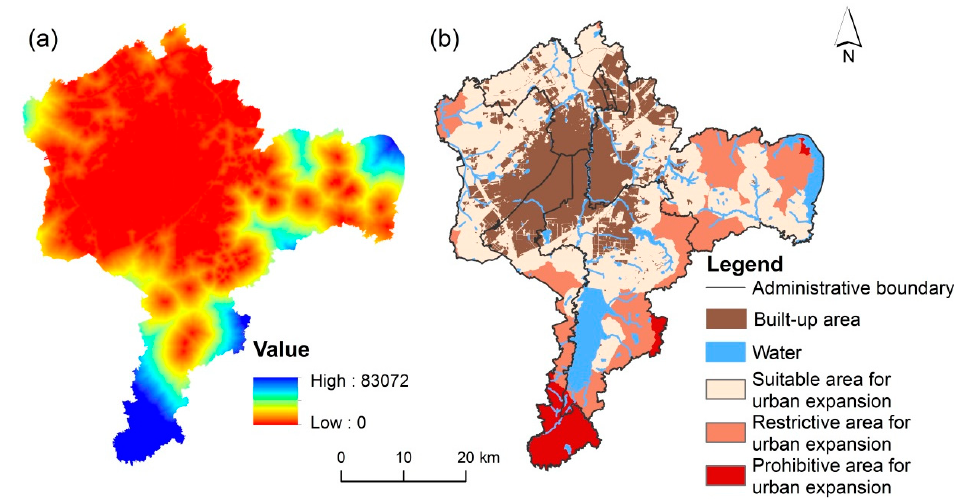
Figure 8. ( a ) Minimal cumulative resistance surface and ( b ) urban expansion suitability pattern.